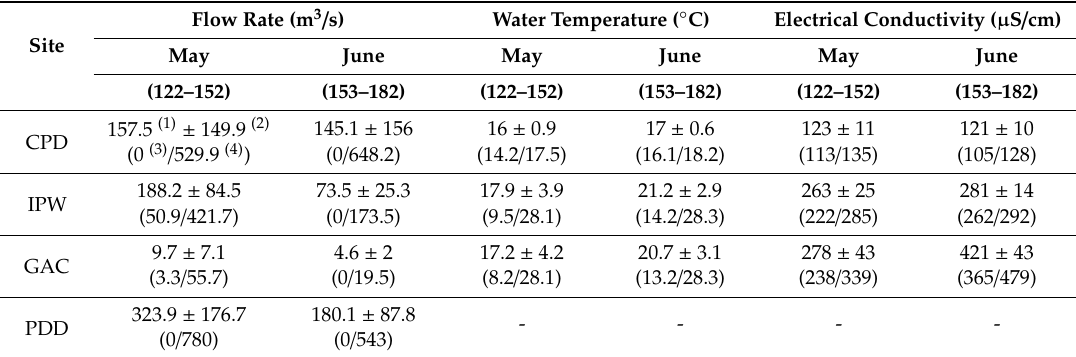
Table 1. Variations in flow rate, water temperature and electrical conductivity at main boundary conditions between Julian day 122 to 152 (May 2016) and 153 to 182 (June